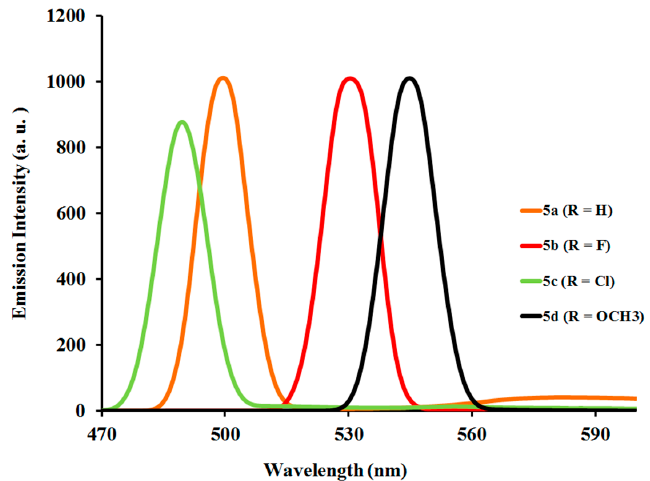
Figure 8. Phosphorescence emission spectra of (Ir( 5a – d ) 3 ) at λ ex = 350 nm in methanol (concentration 2.0 × 10 − 7 mol/L) at RT.